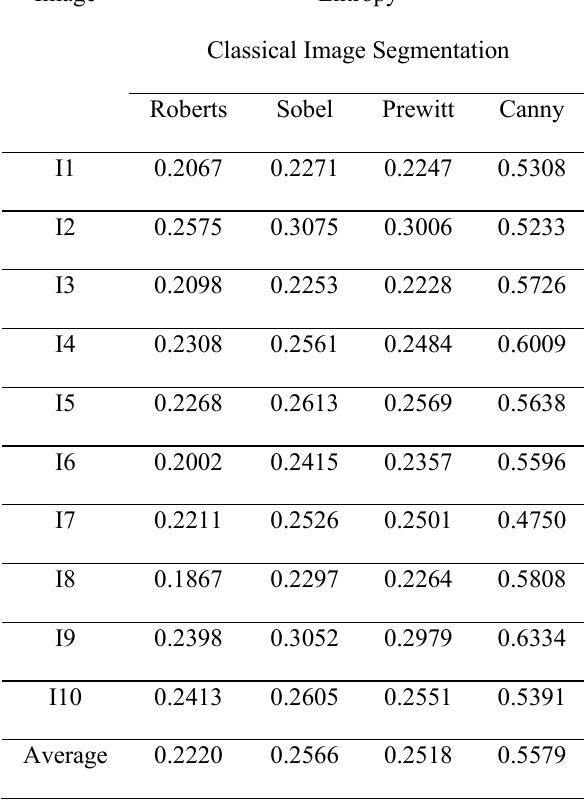
Table 1. Entropy for Classical Image Segmentation